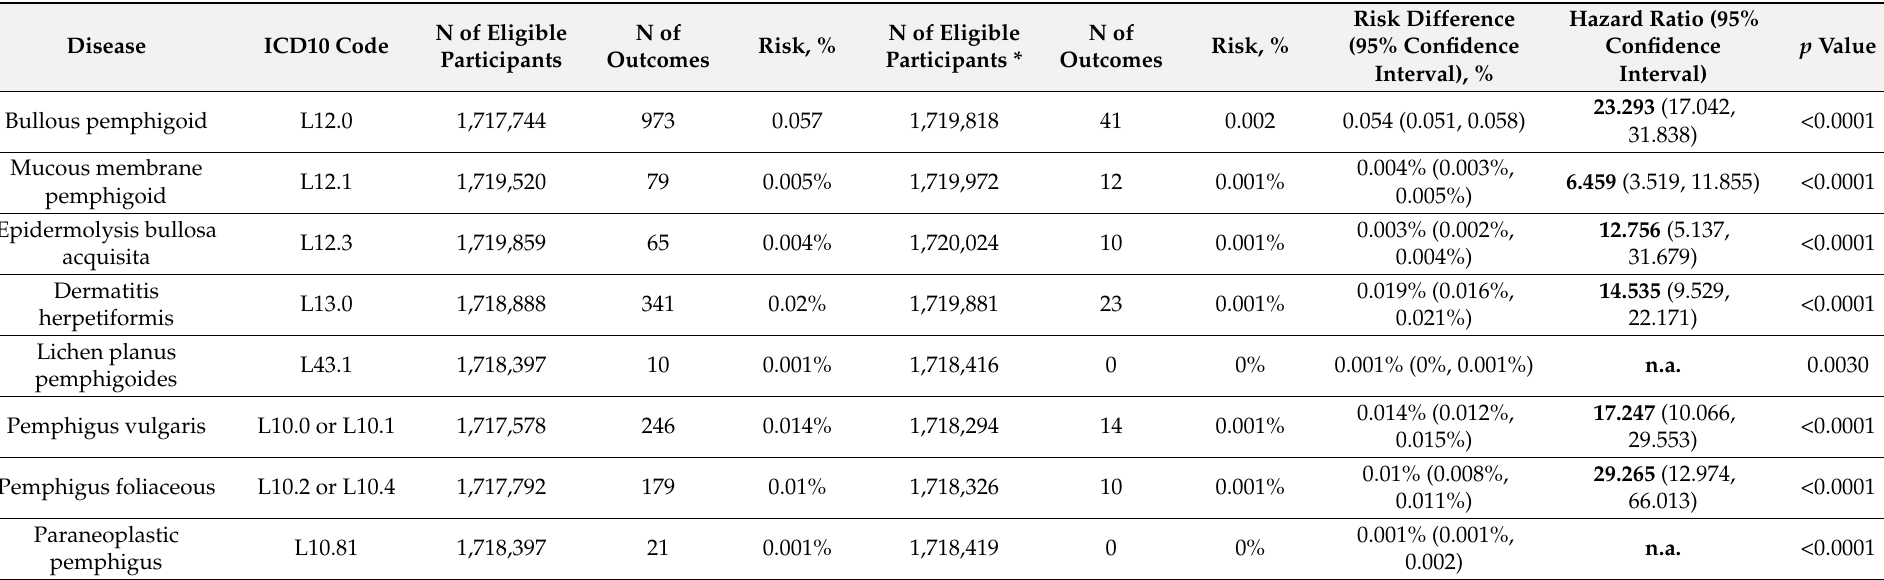
Table 4. Pruritus is associated with a higher risk for the development of pemphigus and pemphigoid diseases (6 months follow-up). The risk of developing any of the listed pemphigus or pemphigoid diseases individuals diagnosed with pruritus (cases, ICD10:L29) compared to those without (controls, ICD10:Z00, not ICD10:L29) within six months after the diagnosis of pruritus. Data shown display results from measures of association, excluding patients with the corresponding pemphigus or pemphigoid disease prior to the time window for the hazard ratio. Kaplan-Meier analysis (again excluding patients with outcome prior to the time window) with log-rank test was performed. Abbreviations: N: number, n.s.: not significant, n.a.: not applicable. Pemphigus or pemphigoid diseases where presence of pruritus increases the risk are highlighted in bold. Please note that propensity score matching is re-run with analysis of each outcome so that the analysis uses the most current data available on the TriNetX network. Analysis was performed on 11 October 2022. * Cases and controls with elevated bilirubin or urea nitrogen concentrations in serum, plasma, or blood were excluded from